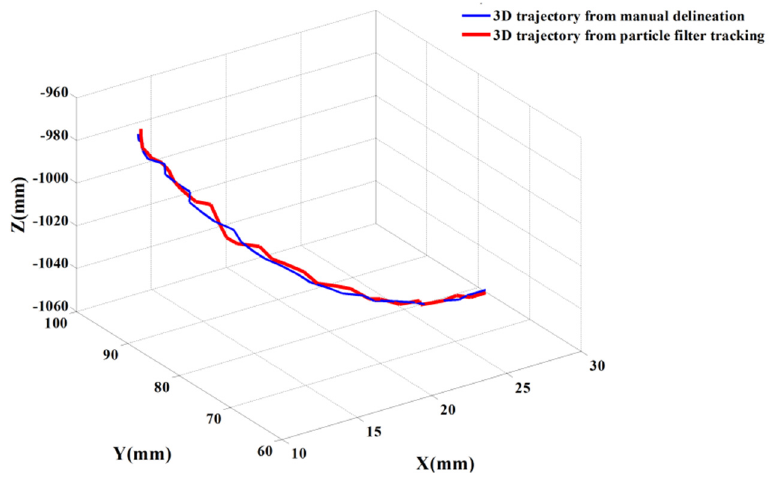
Figure 8. 3D trajectories of the catheter.